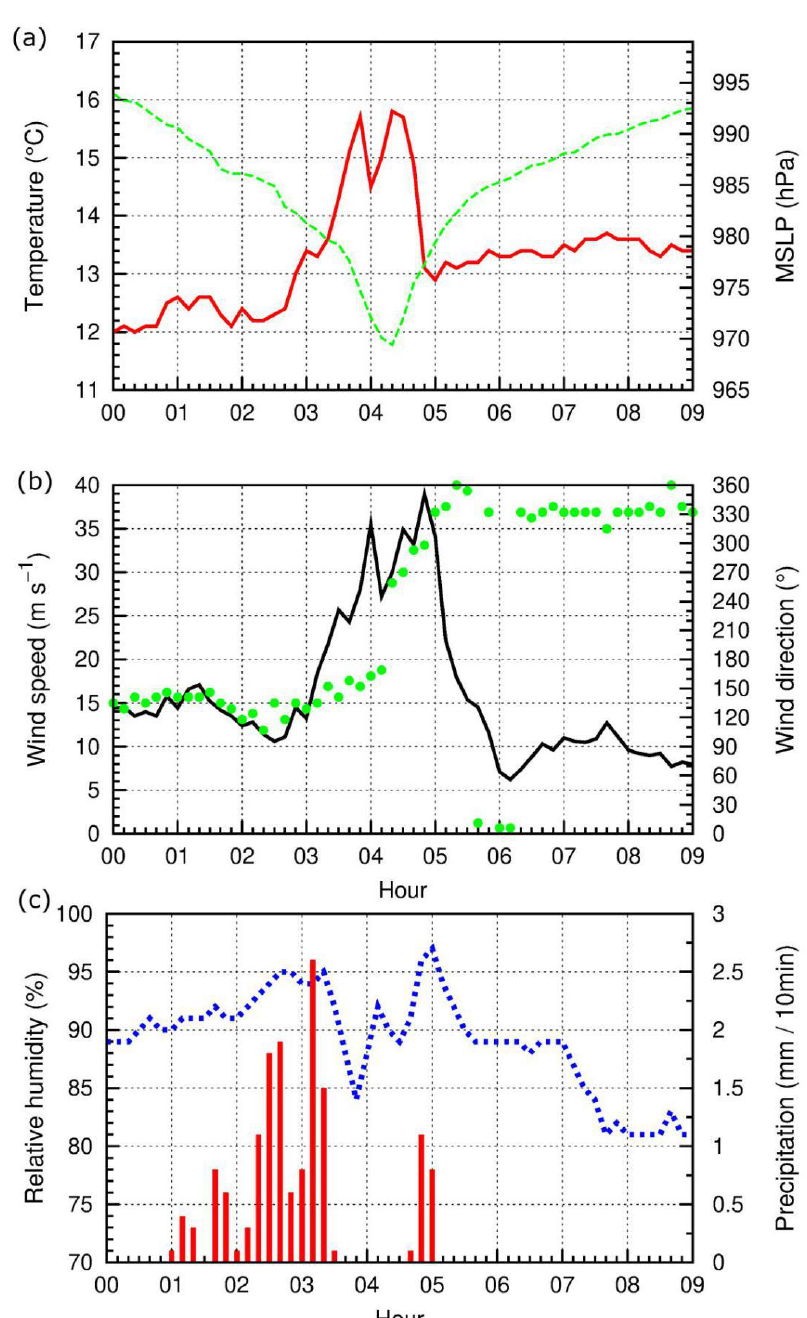
Figure 13. Time evolution of ( a ) 2-m temperature and MSLP, ( b ) wind gust and wind direction at 10 m, and ( c ) relative humidity and 10-min accumulated precipitation at the station of Cabo Carvoeiro (see its location in Figure 1d).